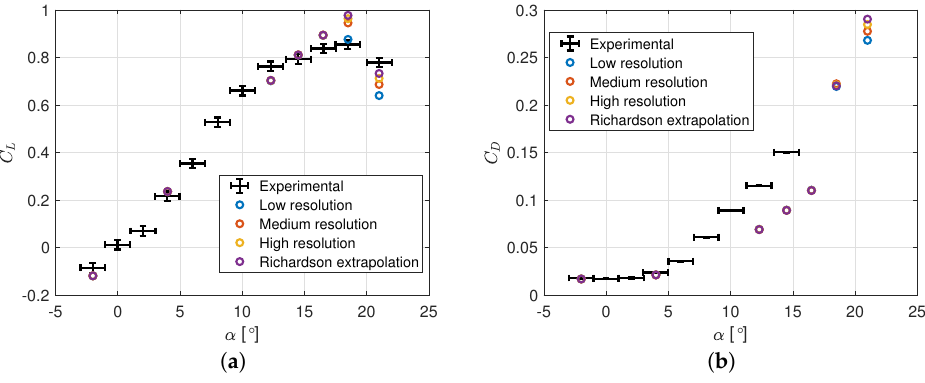
Figure 9. ( a ) C L vs. α curve (OpenFOAM); ( b ) C D vs. α curve (OpenFOAM)